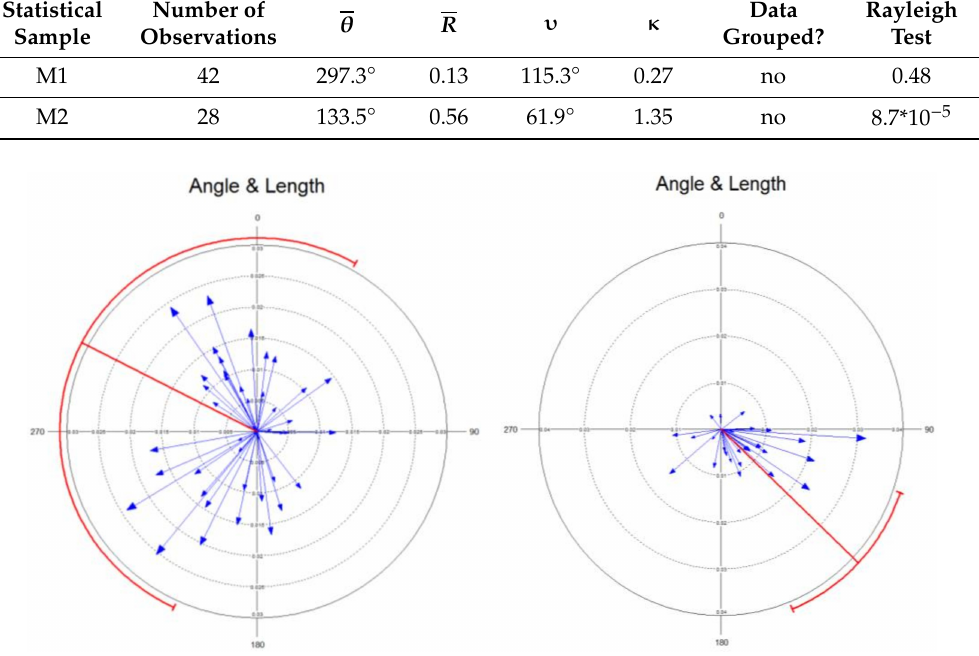
Figure 9. Graphs of distribution of angular and linear magnitudes in samples M1 and